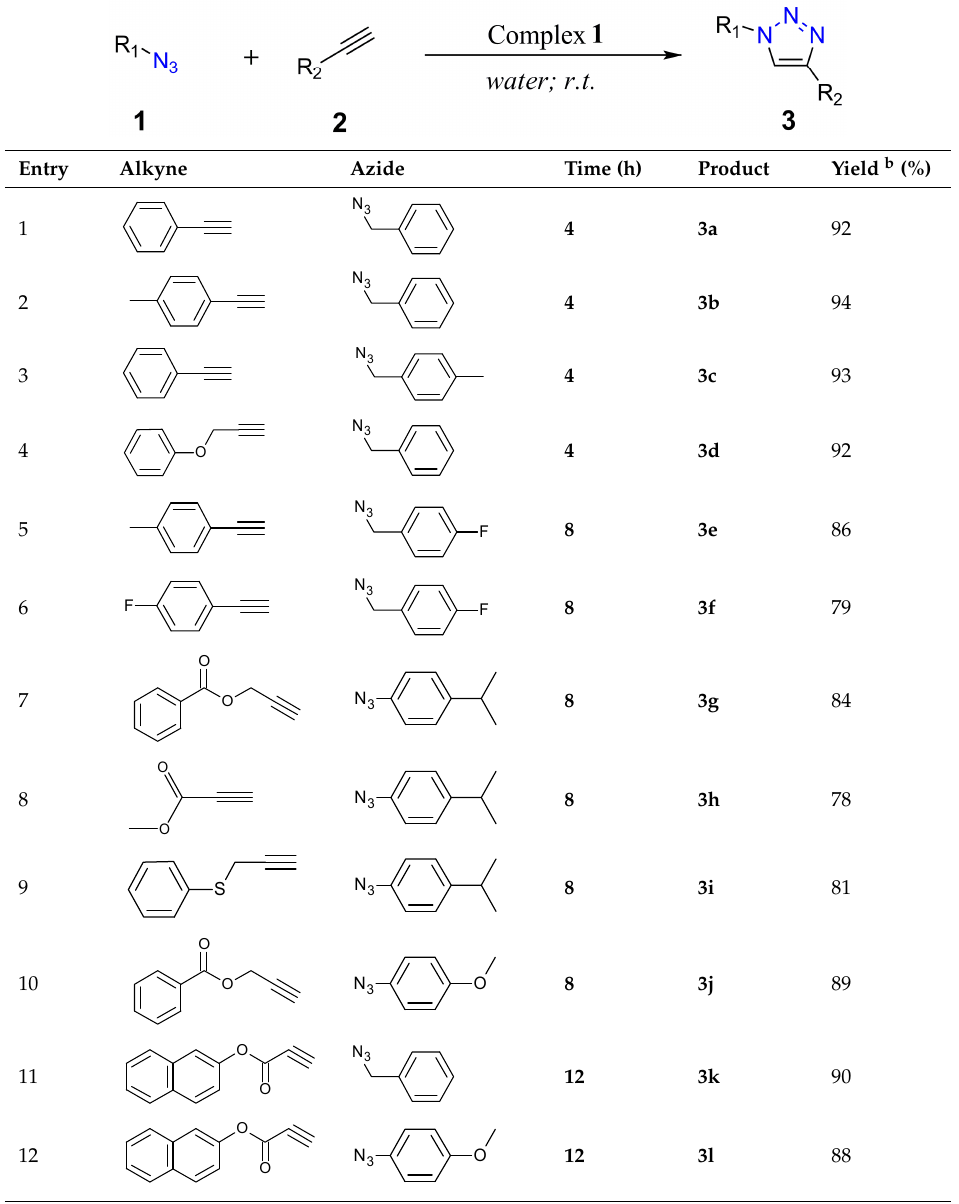
Table 3. Click of 1,2,3-triazoles in the presence of complex 1 a .